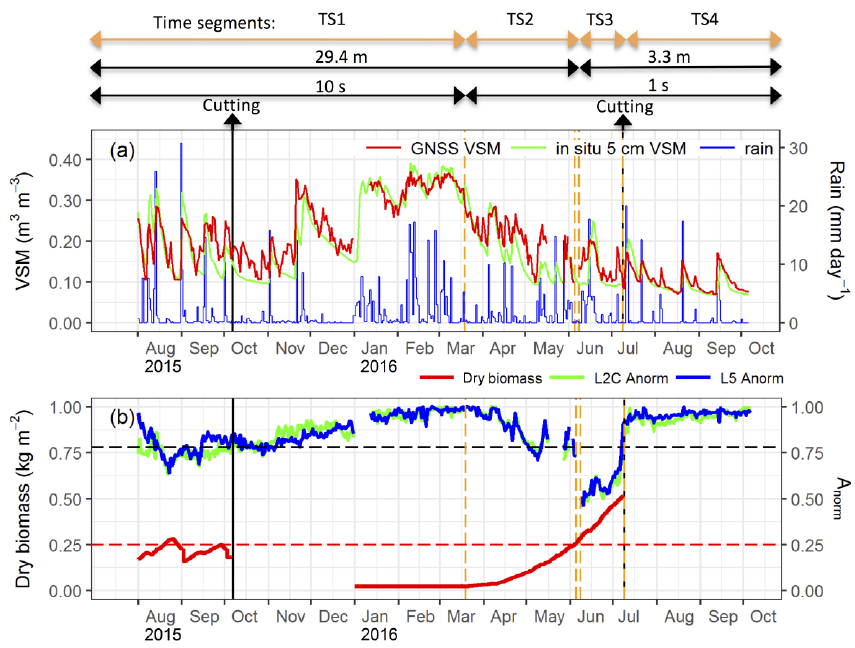
Figure 2. Timeline of experiment. (a) Daily GNSS VSM retrieval time series ( N = 409) using both L2C and L5 SNR data for the whole experimental period (from 1 August 2015 to 6 October 2016) is shown in red line, together with daily mean in situ VSM observations at a depth of 5cm (green line). The blue line represents the daily precipitation in mmday − 1 . The black lines indicate the grass cutting before 7 October 2015 and before 9 July 2016. The retrievals are obtained separately depending on four time segments (Table 2). (b) The red line represents the aboveground dry biomass (kgm − 2 ) of the grass simulated by the ISBA model before grass cutting; the red dashed line indicates the maximum simulated dry biomass (0.25kgm − 2 ) in 2015. Grass cutting is also shown in black solid lines. The L2C (L5) SNR normalized amplitude ( A norm , dimensionless) time series is shown in green (blue). Normalization is performed separately for TS1 and TS2, and for the period with data acquired from the 3.3m antenna using a 1s sampling interval. The latter corresponds to the merged TS3 and TS4. The black dashed line indicates the A norm threshold (0.78) for evaluating the vegetation effects. Table 1. Characteristics of the selected satellite tracks from the GNSS antenna at a 29.4m height and at a 3.3m height (north is 0 ◦ azimuth angle, clockwise